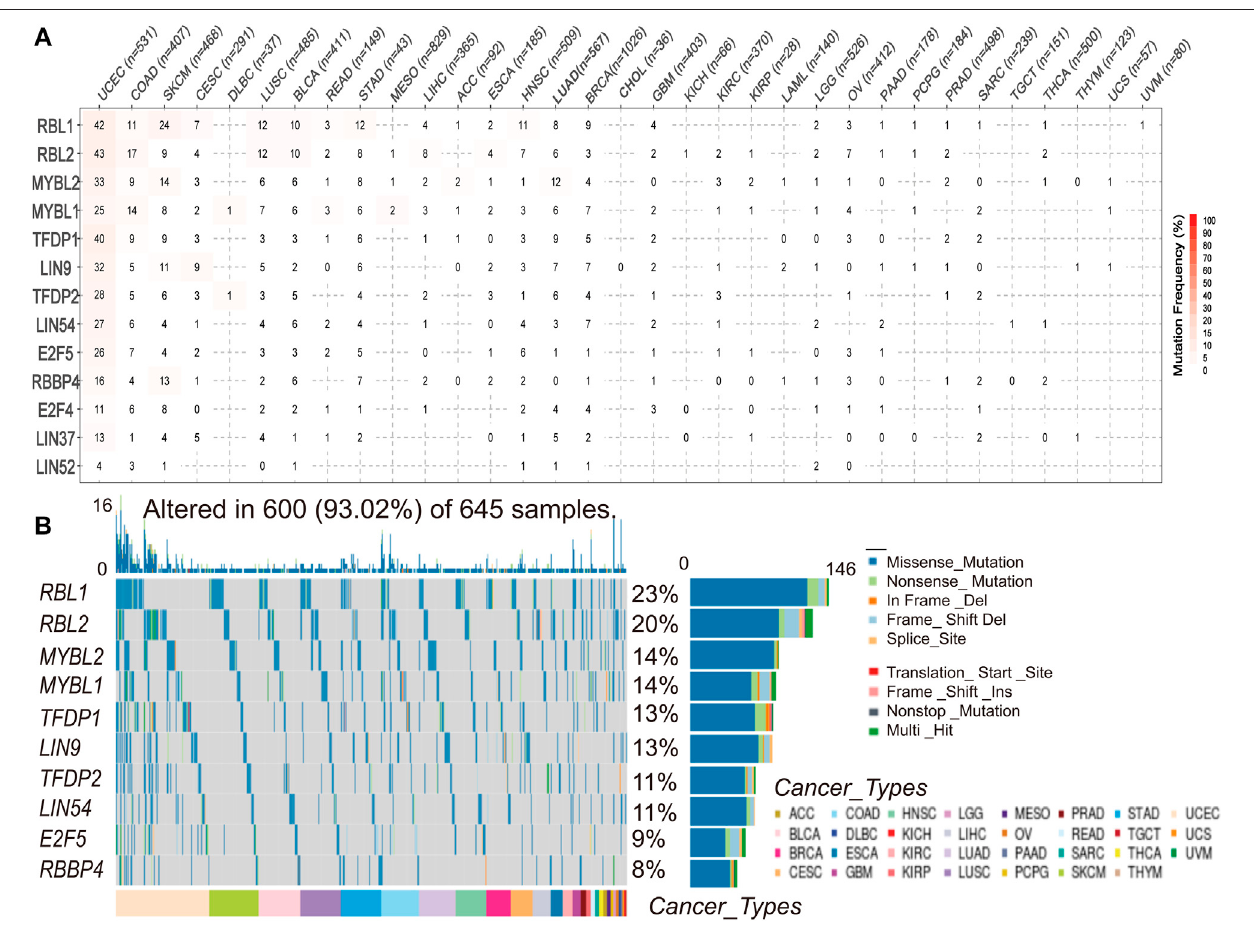
FIGURE 2 | Singlenucleotidevariation(SNV)frequencyandvarianttypesoftheDREAMcomplex. (A) MutationfrequencyoftheDREAMcomplex.Thenumberindicates the number of sampleswithcorresponding mutations in a speci fi c cancer. “ 0 ” means that there is no mutation in the coding region of the gene,and no number indicates that therearenomutationsinanyregionofthegene. (B) SNVoncoplot.Thewaterfallchartshowsthemutationdistributionandclassi fi